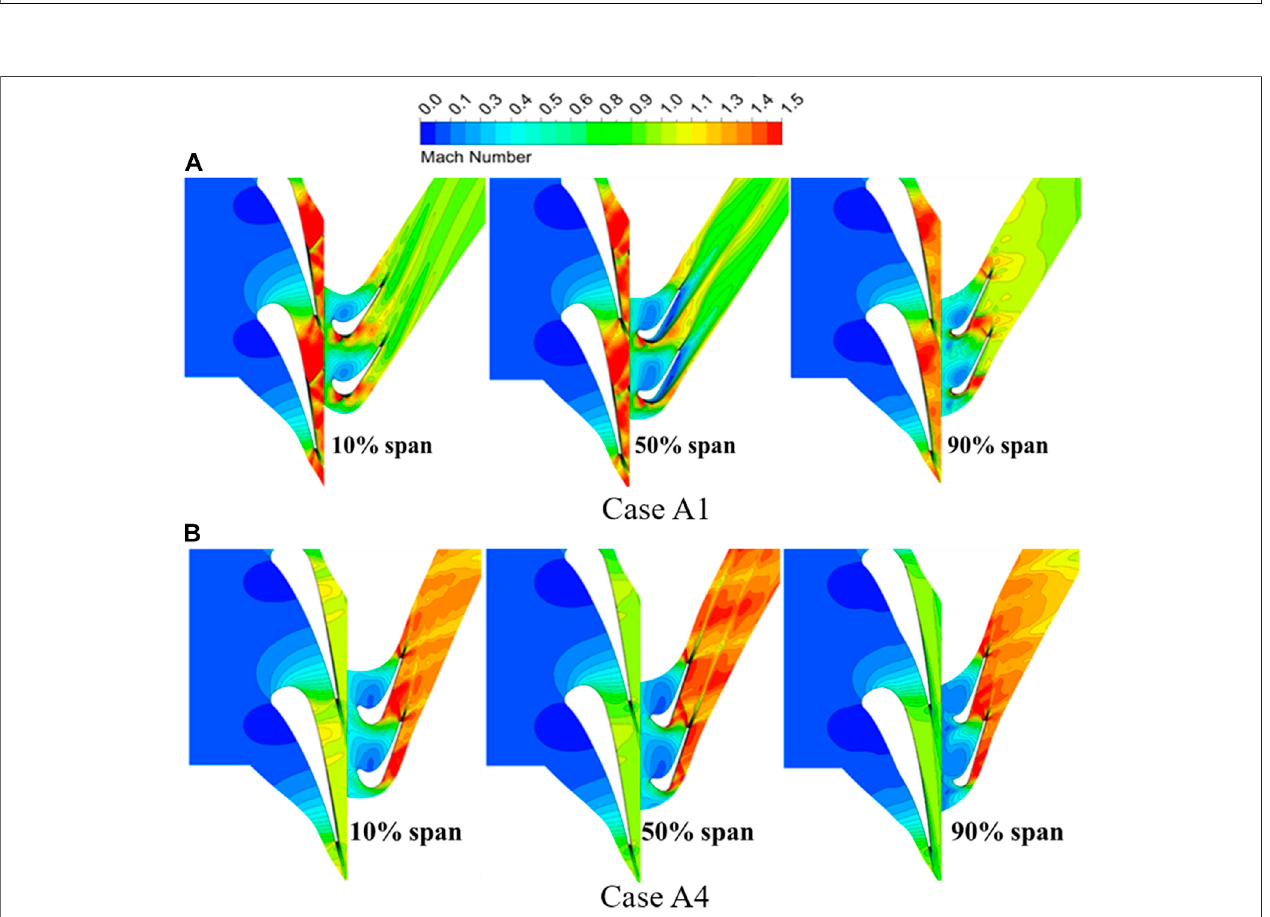
FIGURE 5 | Mach number distribution for different blade height sections between Case A1 and A4. (A) Case A1. (B) Case A4.